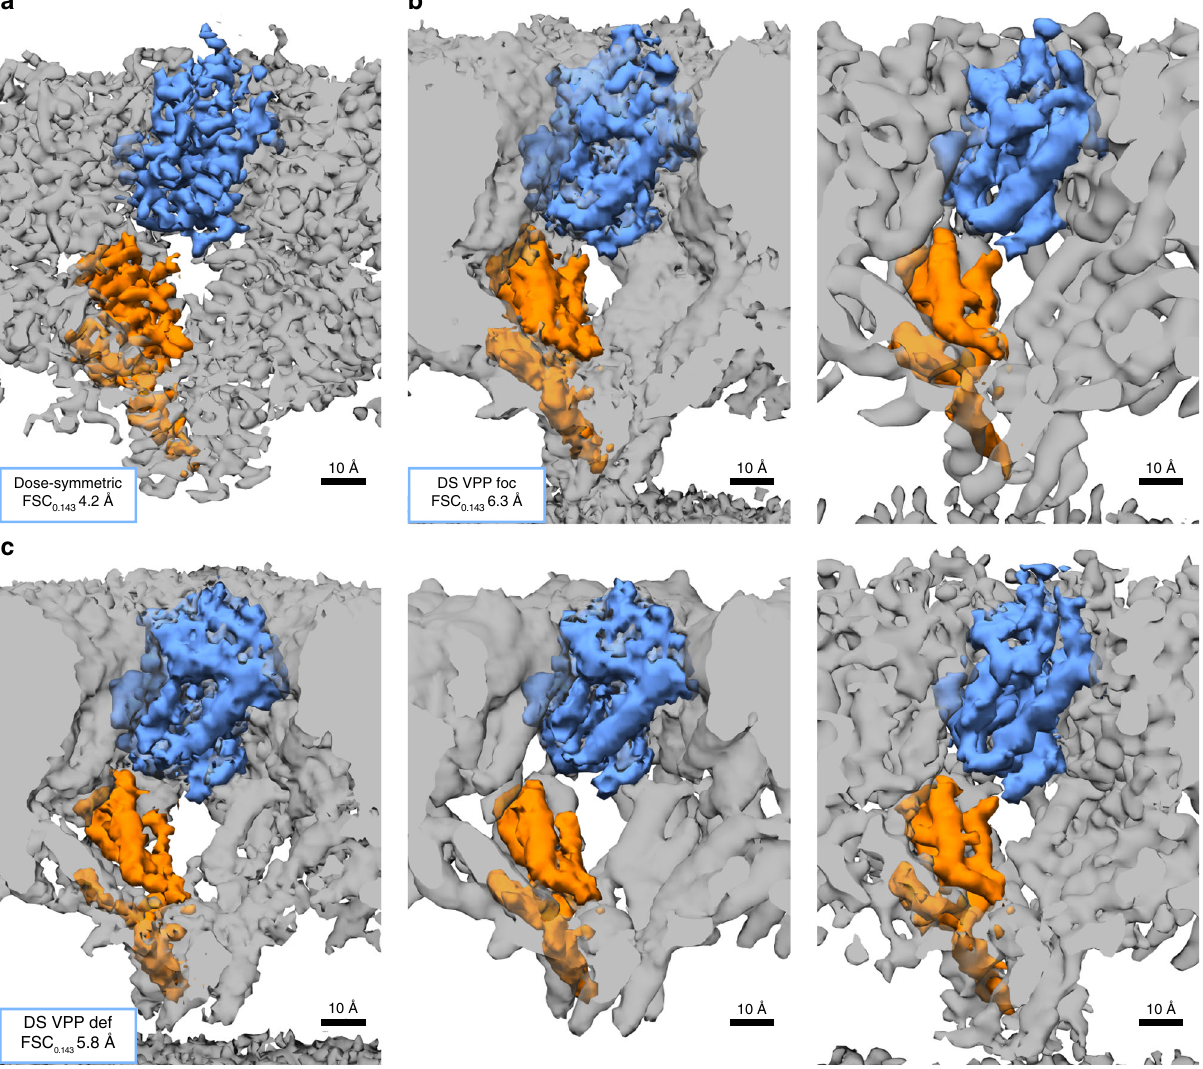
Fig. 4 Cryo-EM maps of HIV-1 CA-SP1. a Structure obtained by the dose-symmetric scheme (after CTF-reweighting and sharpening). b A raw structure obtained from DS VPP foc scheme and its sharpened version (right). c Raw structure obtained from DS VPP def scheme, corresponding CTF-reweighted structure (middle) and fi nal structure after CTF-reweighting and sharpening (right). All images are color coded according to a single chain from PDB 5L93 of HIV-1 CA-SP1 (see Fig. 3 for Table 2 In fl uence of the tilt-series alignment precision on fi nal resolution of the structure solved from the dataset obtained from DS scheme.